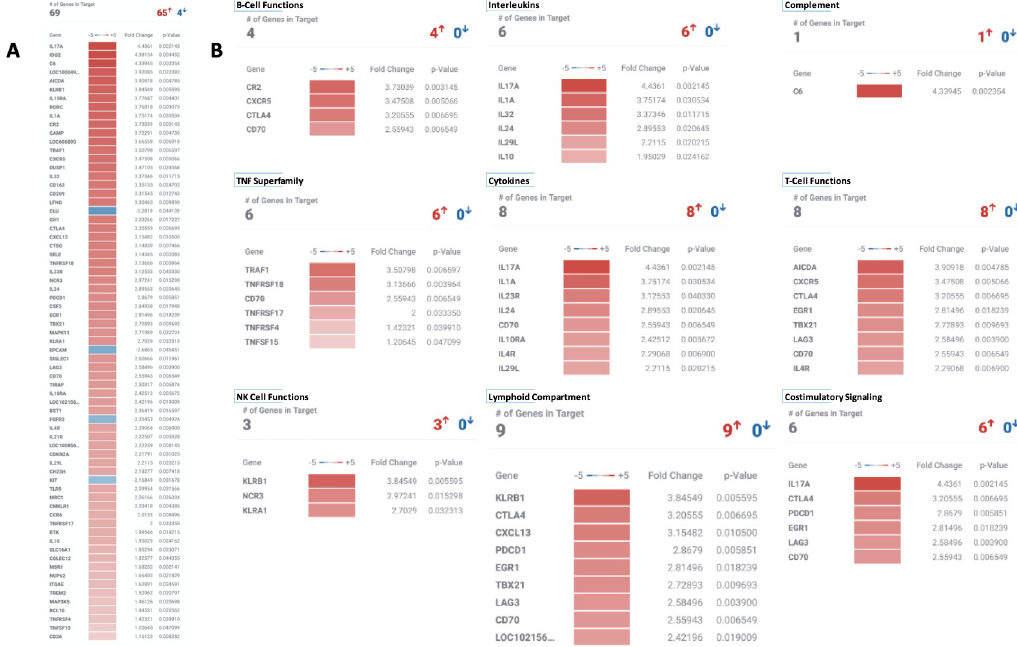
Fig 5. Differential canine immuno-oncology gene expression at day 6 post initiation of therapy. (A) Overall, 65 genes had significantly increased expression and 4 genes had significantly decreased expression compared to pretreatment samples. (B) Clustering of differential gene expression changes by biologically relevant immuno-oncology